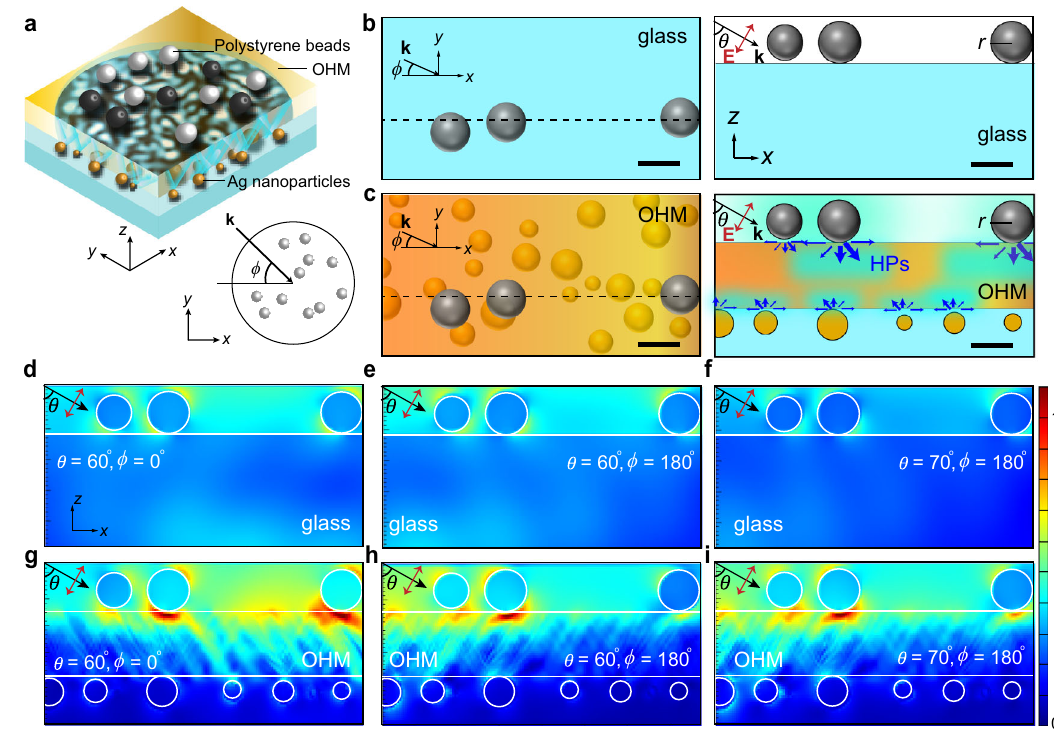
Fig. 2| Tailored scatteringofdielectricnanoparticlesbyOHMs.a – c Schematics of light scattering by dielectric nanoparticles (polystyrene, refractive index n =1.6, radius r =40nm) situated on glass ( b ) and on OHM ( c ). Scale bar: 100nm. d – i FDTD-calculated near- fi eld intensity distribution inthe vicinity of the